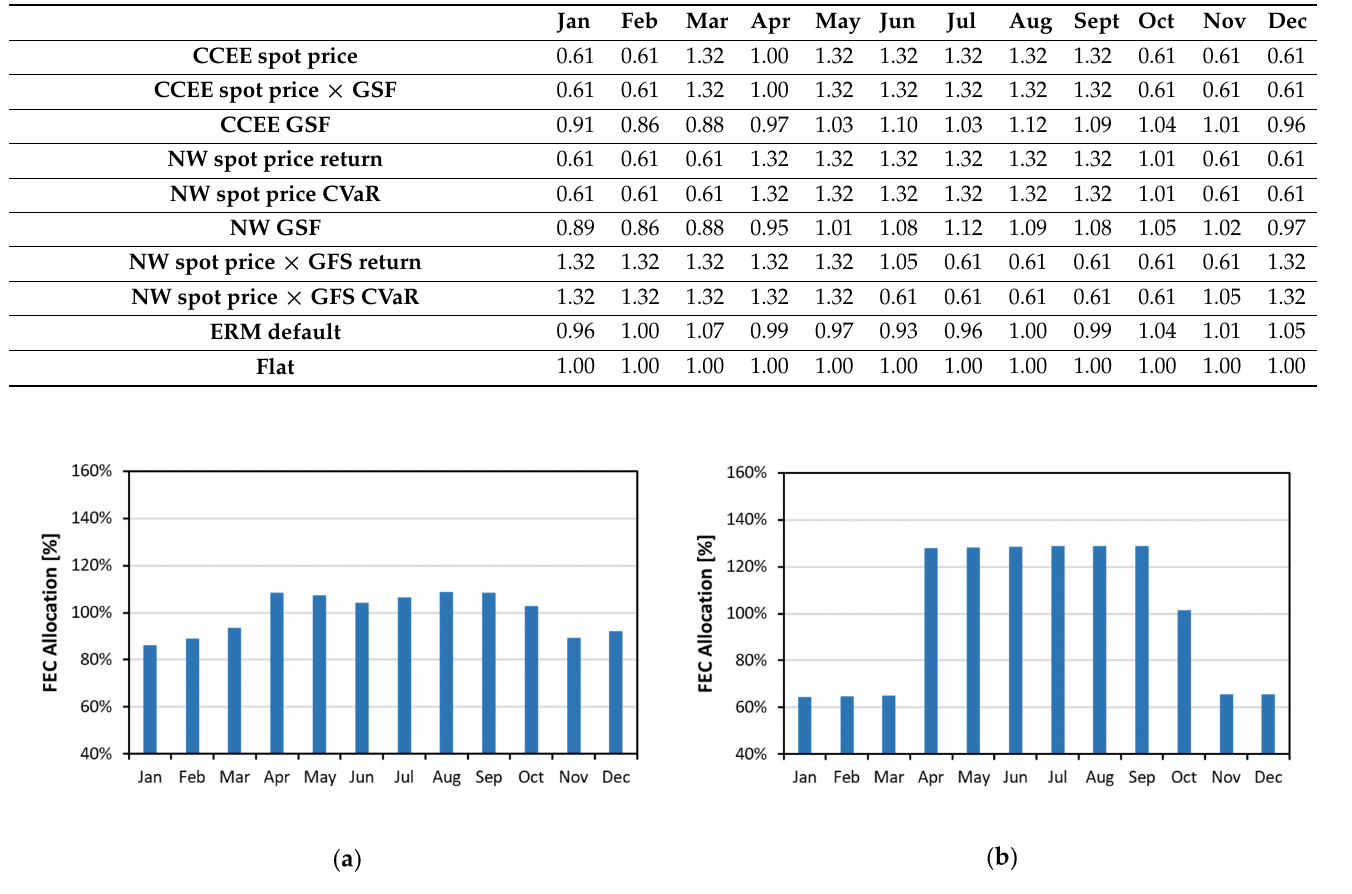
Table 2. FECMA factors for 2019